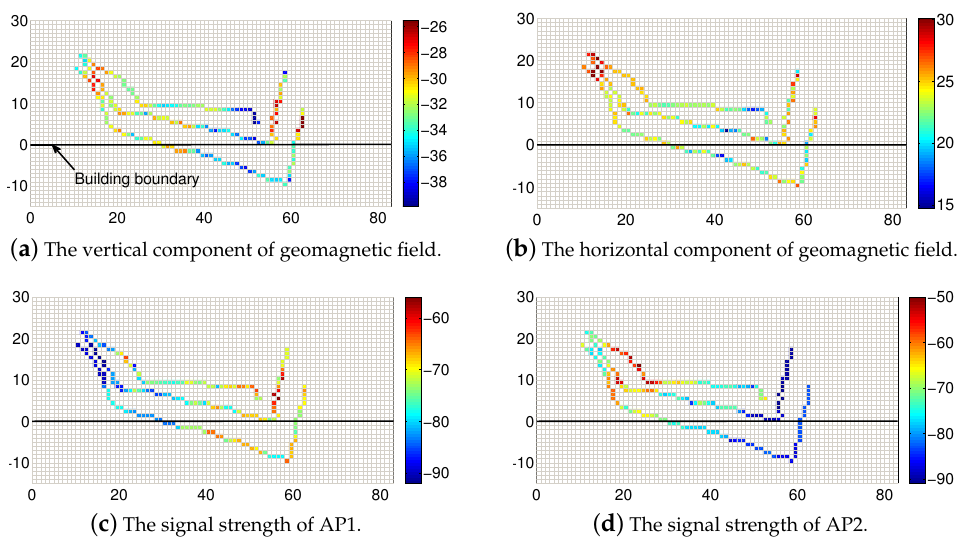
Figure 9. The ambient data map on different